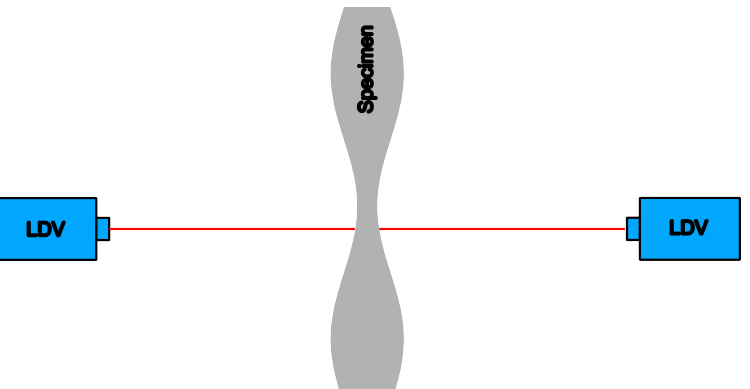
Figure 9. A sketch of the experimental setup illustrates to congruence of the measurement points on the top and bottom surface of a